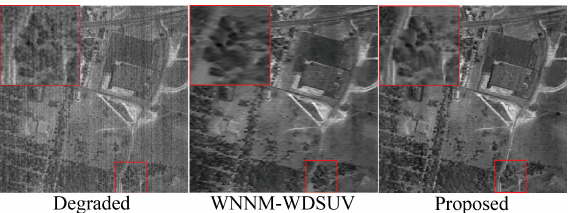
Figure 1. A visual comparison example between a combination method and our unified